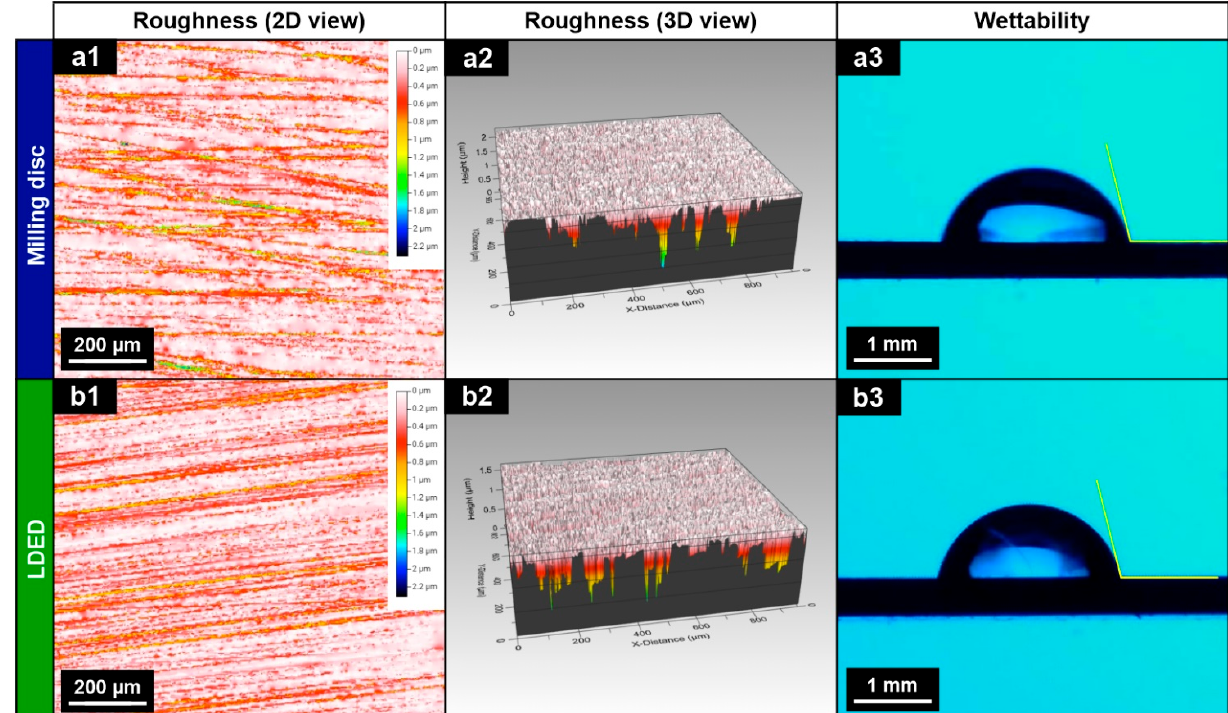
Figure 8. Summary of surface characteristics of the materials before veneering processes: 2D surface view ( a1,b1 ), 3D surface view ( a2,b2 ) and contact angle ( a3,b3 ) tests for disc milling ( a1–a3 ) and LDED ( b1–b3 ) techniques.